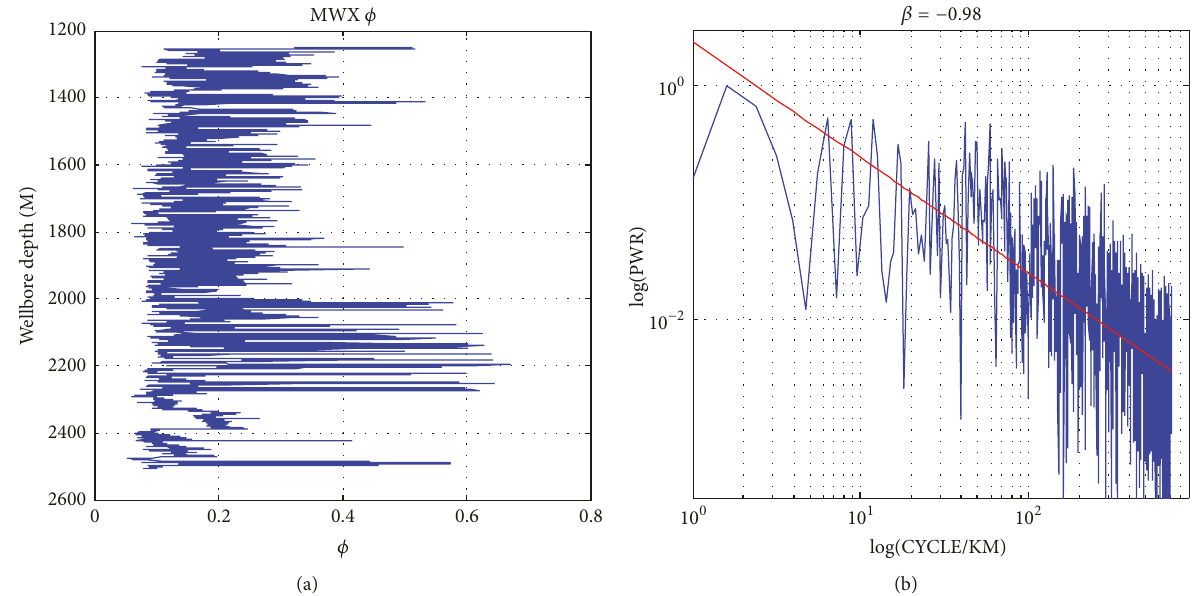
Figure 2: MWX crustal empirical property (5): wellbore neutron porosity log (a) and porosity log power-spectrum with power-law scaling exponent 𝛽 ∼ 0.98 (b).